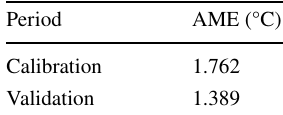
in calibration and validation periods for DO